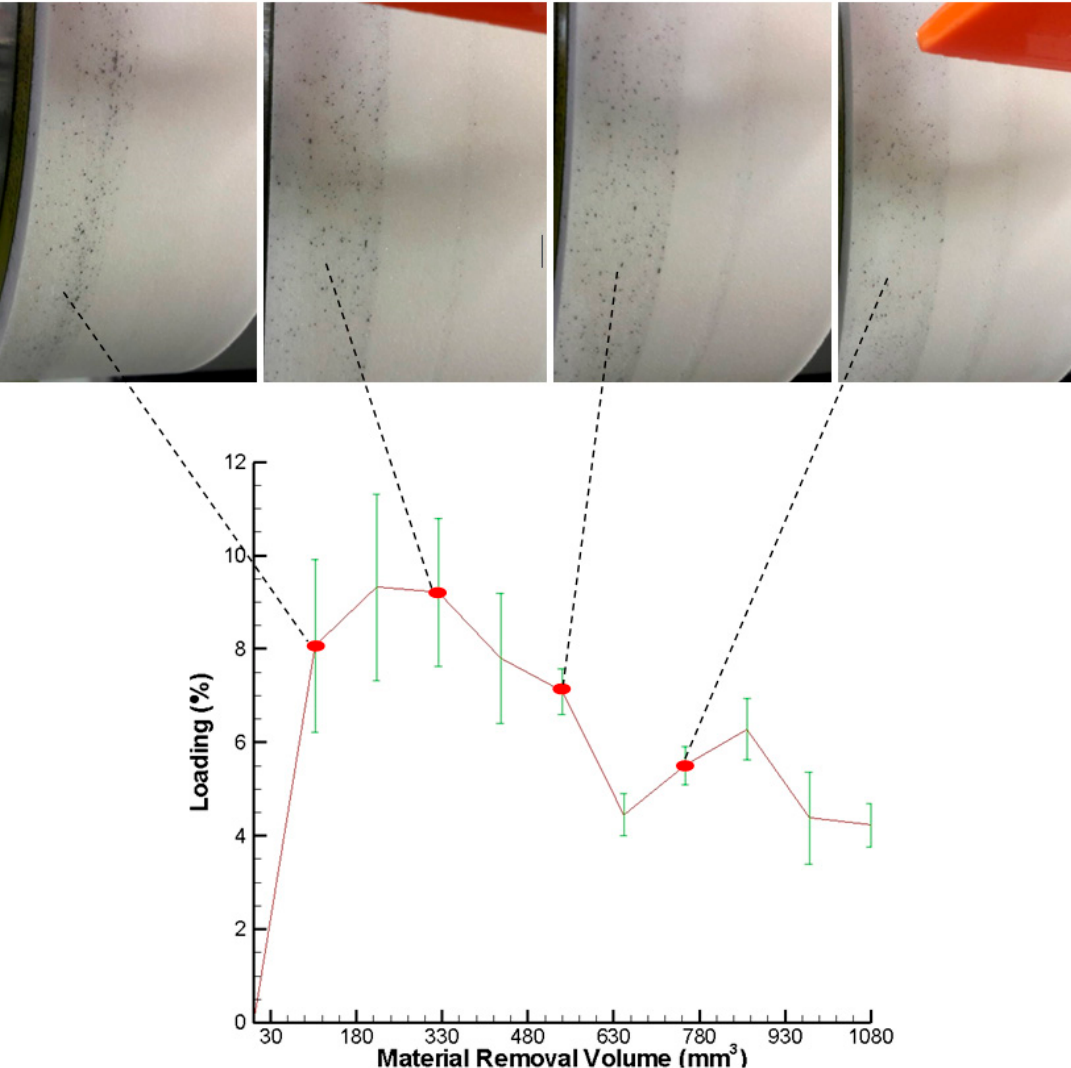
Figure 8. Measured wheel loading over grinding wheel surface and captured wheel loading images.